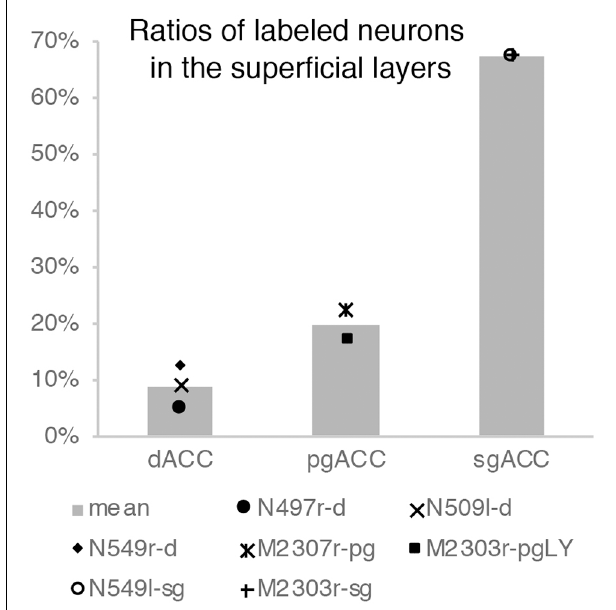
FIGURE 11 | Ratios of labeled neurons in the superficial layers of the TP after tracers were injected into the dACC, pgACC, and sgACC. The graphs show only the results of the cases in which the tracer injection was well confined to the targeted area (see “Results” section).